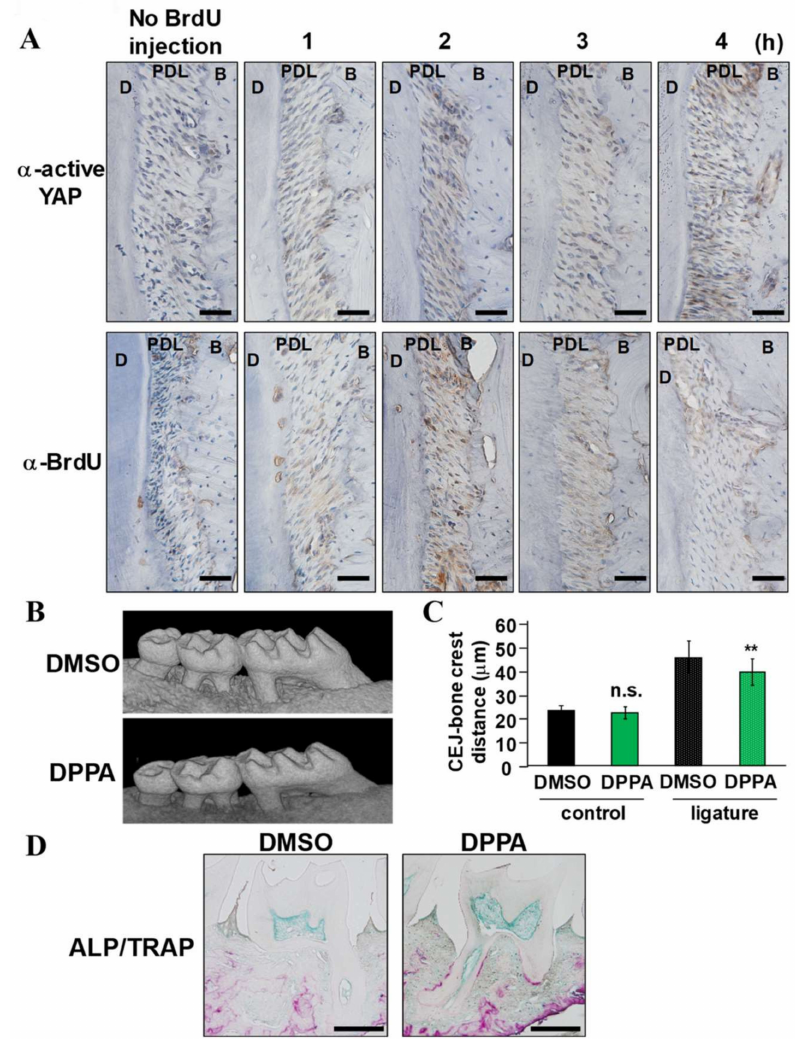
Figure 4. DPPA administration during the regenerative period promotes alveolar bone regenera- tion. ( A ) Twelve-week-old males were intraperitoneally injected with BrdU, housed for 24 h, and then intravenously injected with DPPA for the indicated time. Then, the demineralized sections were stained with α -active YAP and α -BrdU. ( B ) Representative µ CT images of maxilla used for µ CT analy- ses and ( C ) the vertical distances from the CEJ to the alveolar bone crest at the mesial and distal roots on day 14 ( n = 12). ( D ) Demineralized male maxilla sections collected on day 14 were stained with TRAP/ALP double staining. Scale bars correspond to 500 µ m. ** p < 0.01 significantly different from DMSO-treated group. n.s. = not significant, MT = Masson’s trichrome staining, PDL = periodontal ligament tissue, C = cementum, D = dentin, B = bone, P =